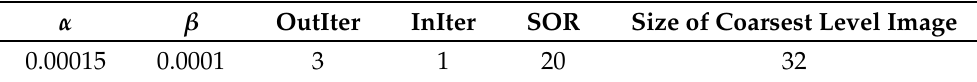
Table 3. The parameters of fine